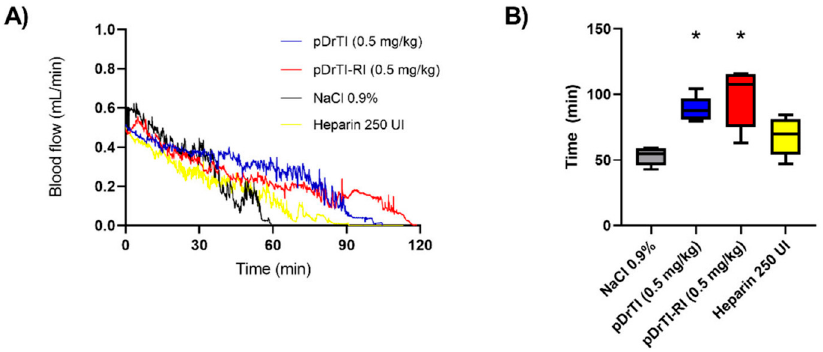
Figure 4. Arterial Thrombosis—The animals were pre-treated with pDrTI, pDrTI-RI, heparin, or NaCl by retro-orbital intravenous injection. The photosensitive dye Rose Bengal was administered and the lesion was induced through a laser incision λ = 542 nm (5 mm diameter) 6 cm away from the artery, and the flow was monitored through a Doppler probe until it was less than or equal to 0.05 mL/min. Blood flow is shown in ( A ) and occlusion time in ( B ). * p < 0.05. N = 5 animals. These data demonstrate the potential of these peptides as antithrombotic drugs. The time required for occlusion of the carotid artery was approximately two-fold that of untreated mice, and these times were similar to those found for the native protein and other Kunitz-type inhibitors such as AsTI and BbKI [8,10].